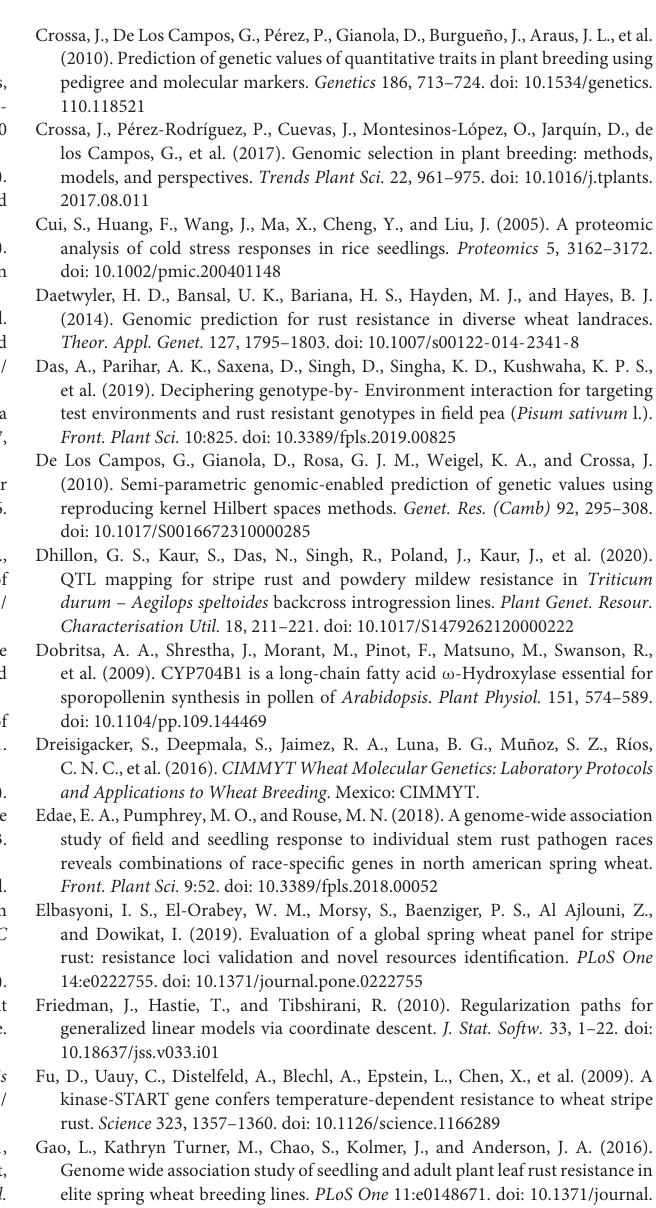
Supplementary Table 5 | Marker trait associations identified using FarmCPU algorithm for rust disease severity scores across four (individual and G × E)